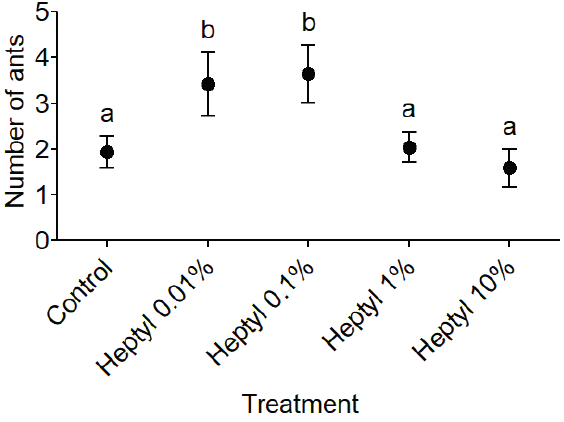
Figure 3 - Number of ants (mean ± SE) walking through filter paper with sugar and impregnated with ethanol (control) or heptyl butyrate 0.01, 0.1, 1 or 10%. Different letters indicate significant differences (p < 0.05, N =